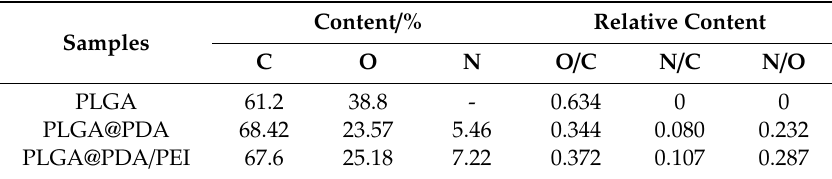
Table 1. The chemical element composition of C, N, and O in the PLGA Microspheres, PLGA@PDA microspheres, and PLGA@PDA/PEI microspheres.